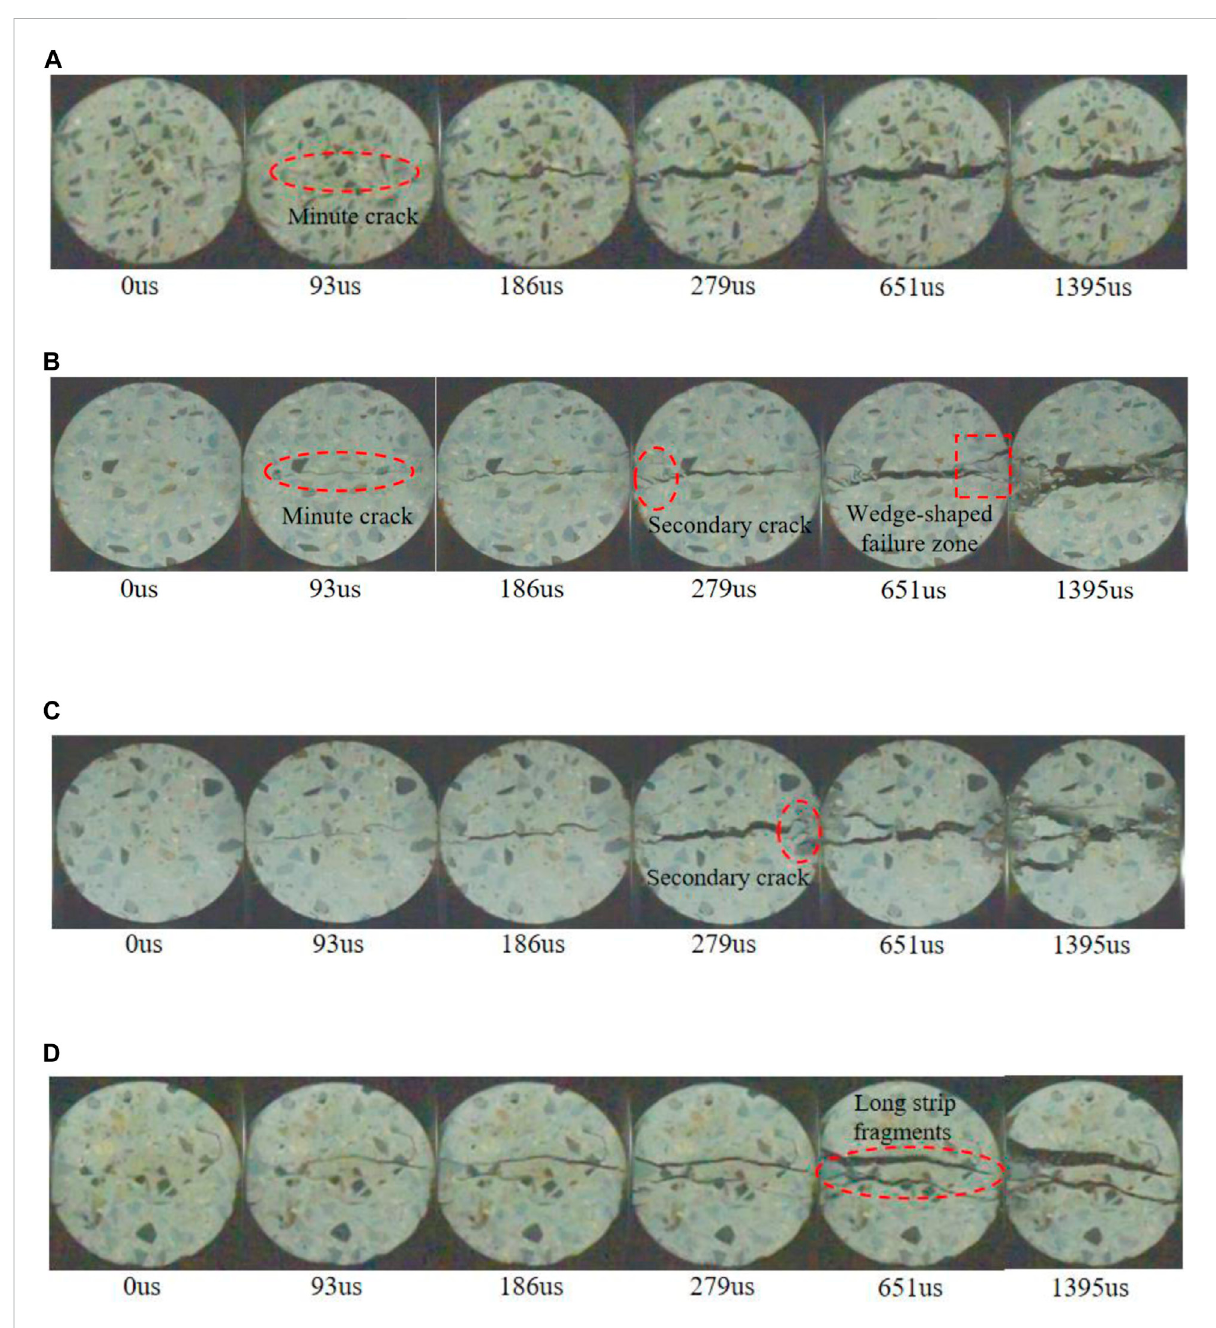
FIGURE 7 Typical failure process of the grouting specimens. (A) _ ε = 24.8 s − 1 , (B) _ ε = 33.2 s − 1 , (C) _ ε = 45.1 s − 1 , (D) _ ε = 46.2 s − 1